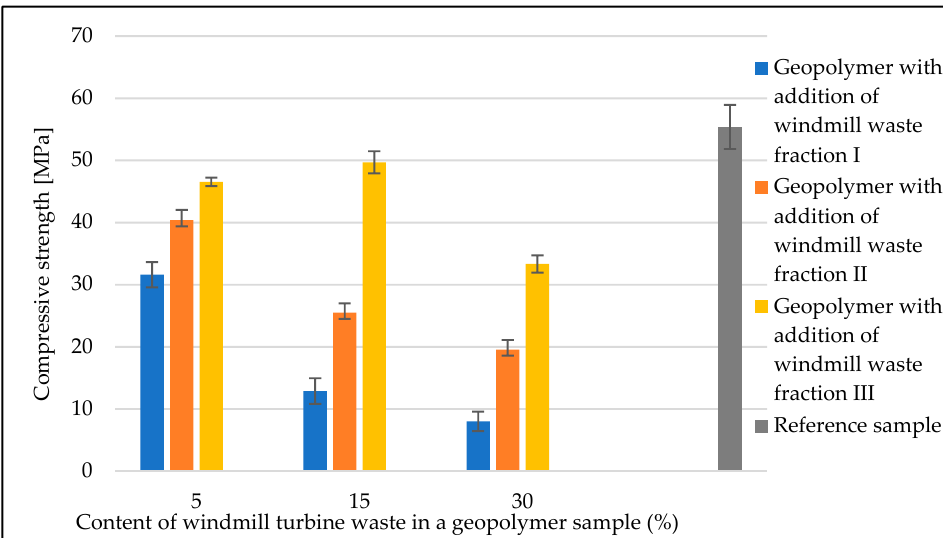
Figure 15. Compressive strength of geopolymer samples with the addition of windmill turbine waste fractions.